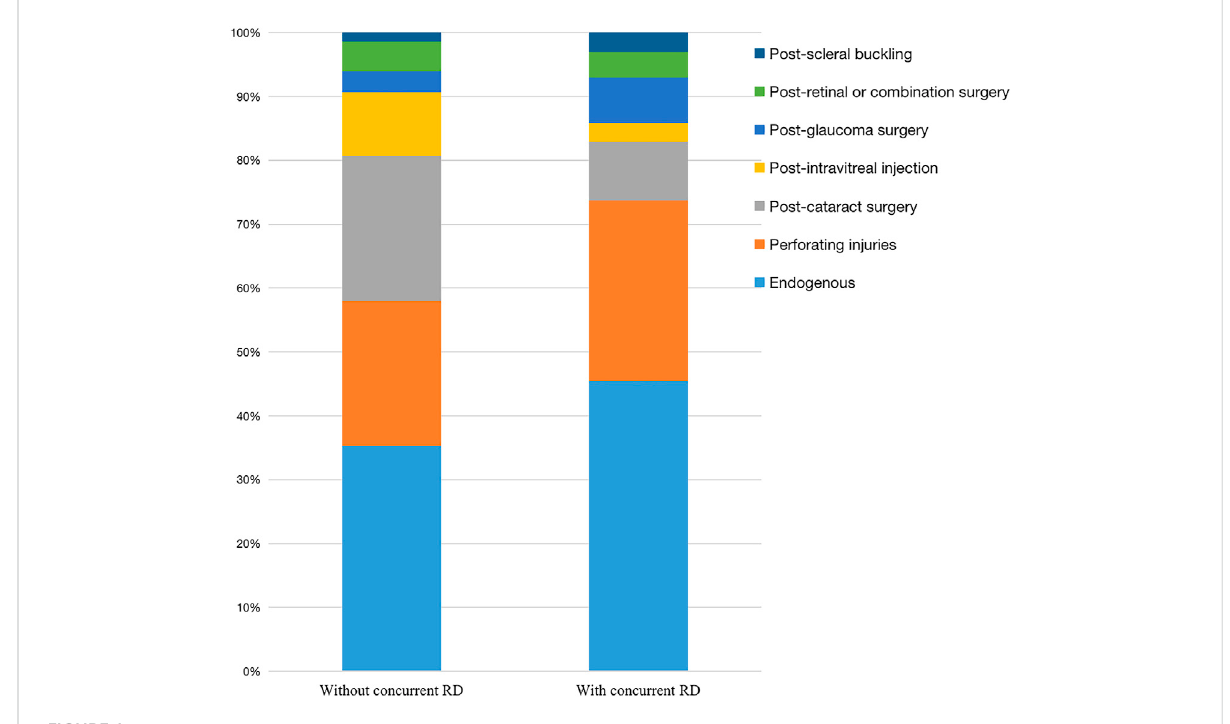
FIGURE 1 Clinical scenarios of eyes with/without concurrent retinal